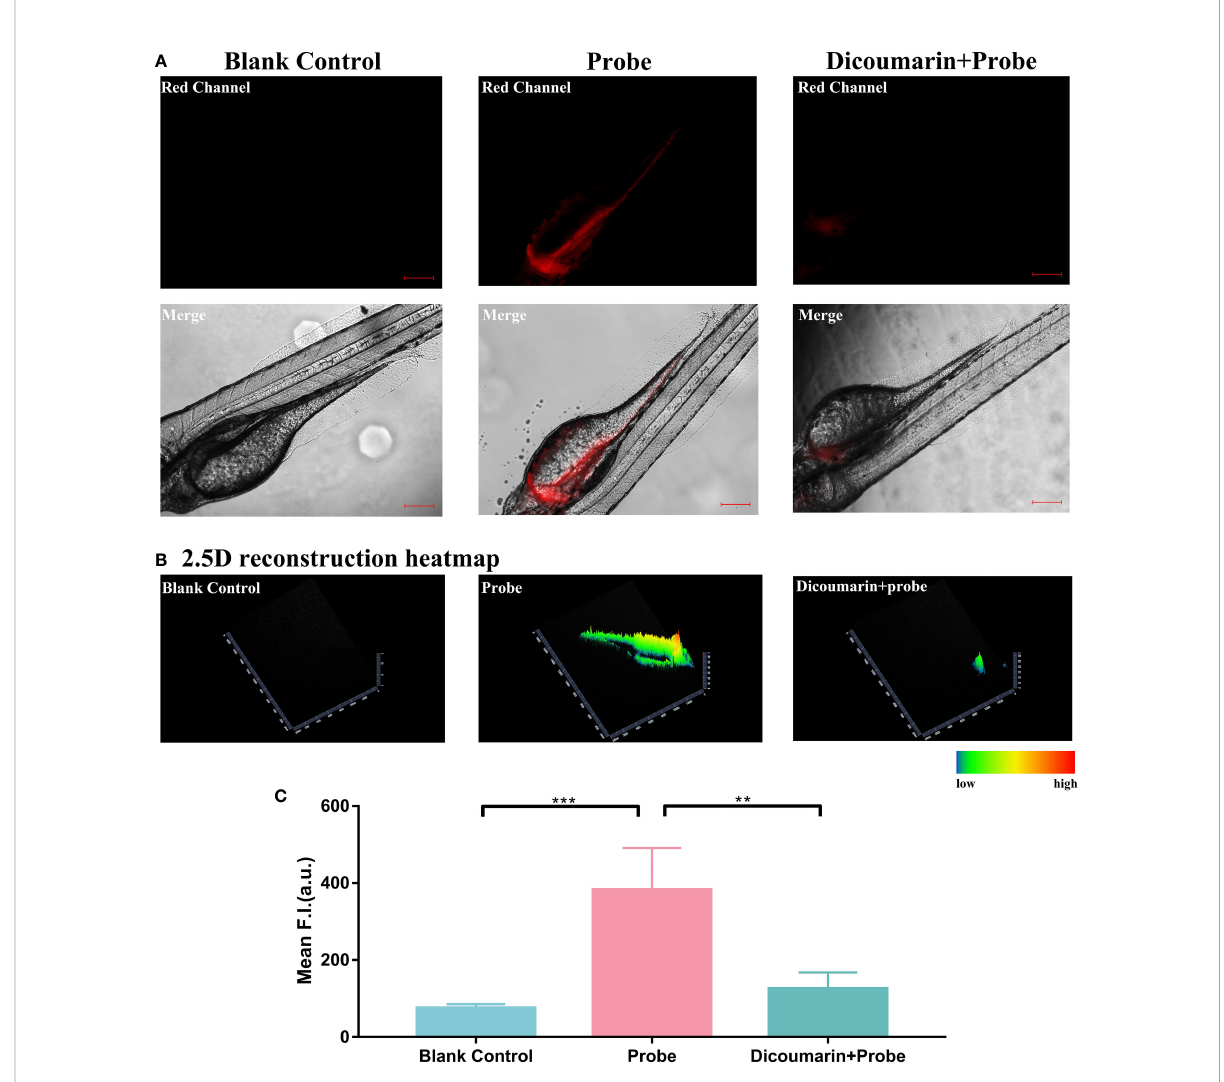
FIGURE 6 (A) Fluorescence imaging of zebra fi sh. Zebra fi sh in blank control group were cultured in E medium; in probe group,they were treated with only HNT-NTR; and in dicoumarin group, they were pretreated with dicoumarin to scavenge NTR and then treated with HNT-NTR. With the blockage of dicoumarin, the fl uorescence signal was evidentially inhibited compared to the probe group (B) The 2.5D heatmaps corresponded to each group. The strongest signal could be found in probe group and weaker signals could be observed in both dicoumarin group and blank control group. (C) Quantitative analysis on the fl uorescence intensity of each group. Signi fi cant difference was identi fi ed between the dicoumarin blockage group and the probe group, demonstrating that HNT-NTR has the potential to monitor NTR level in vivo with